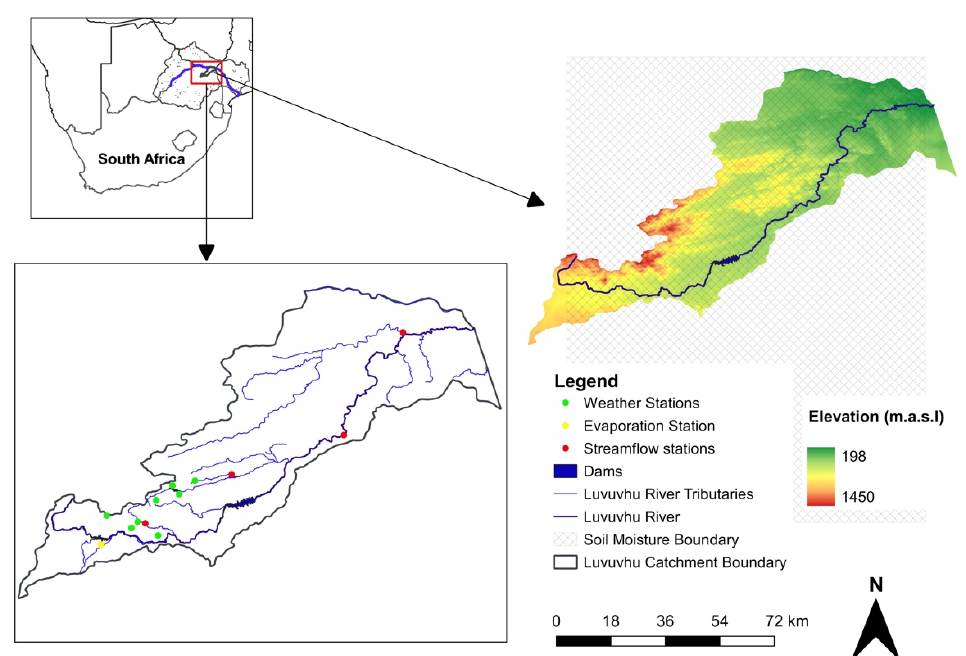
Figure 1. The study area, Luvuvhu River Catchment.